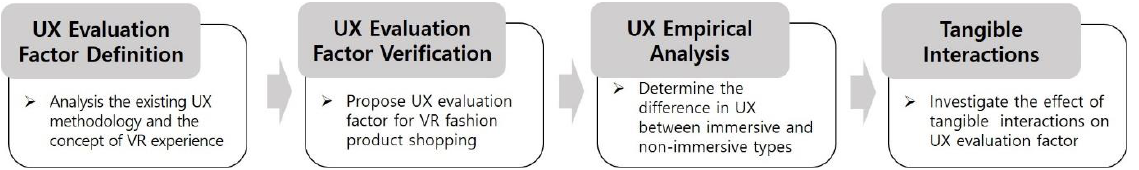
Figure 1. Research flow.